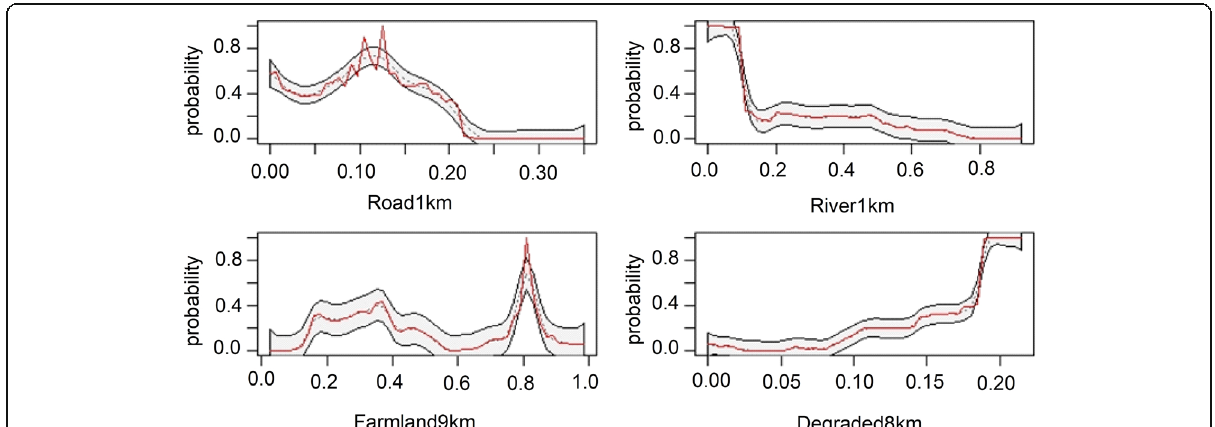
Fig. 5 Partial dependency plots for road density, river density, farmland, and degraded forest patches. The partial dependency plots represent the marginal effect of each habitat variable while keeping the effect of other variables at their average value. The shaded gray region represents 95% confidence intervals, and the red line indicates the average value. The X -axis represents the percentage of the variables ranging from 0 to 1%, and Y -axis represents the predicted probability of sloth bear occurrence